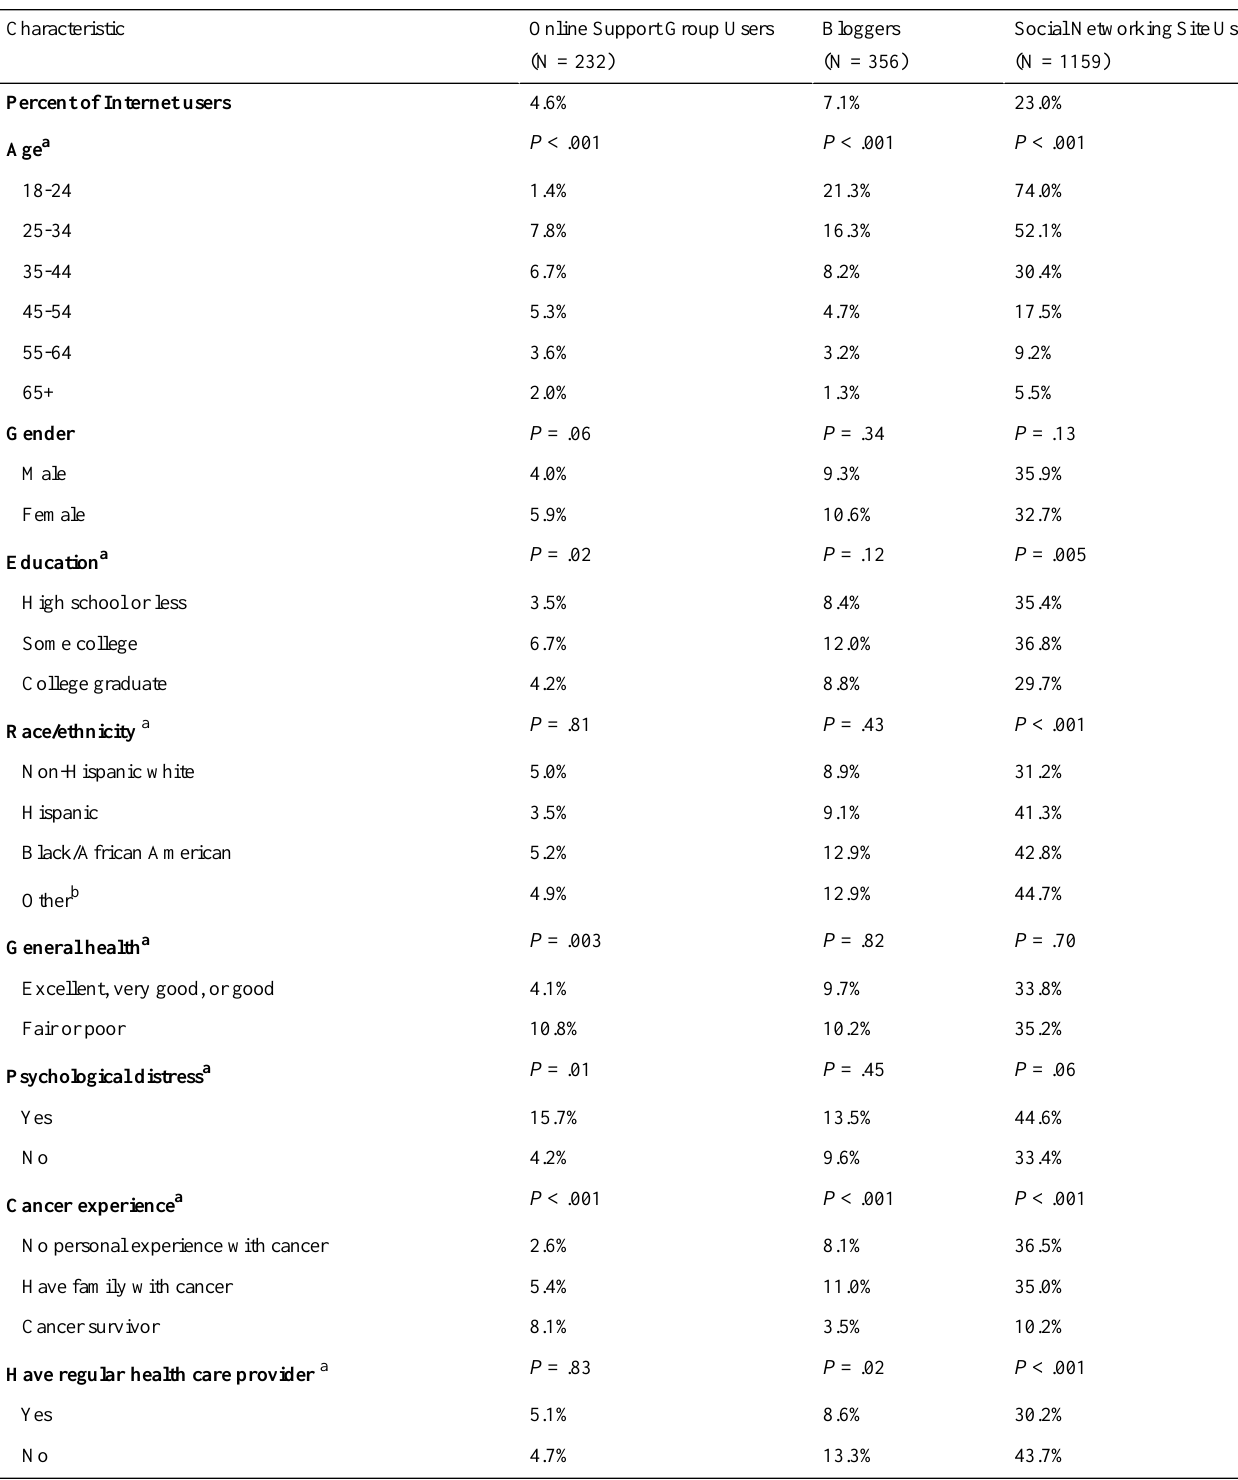
Table 3. Bivariate associations between three types of social media use and study variables: weighted